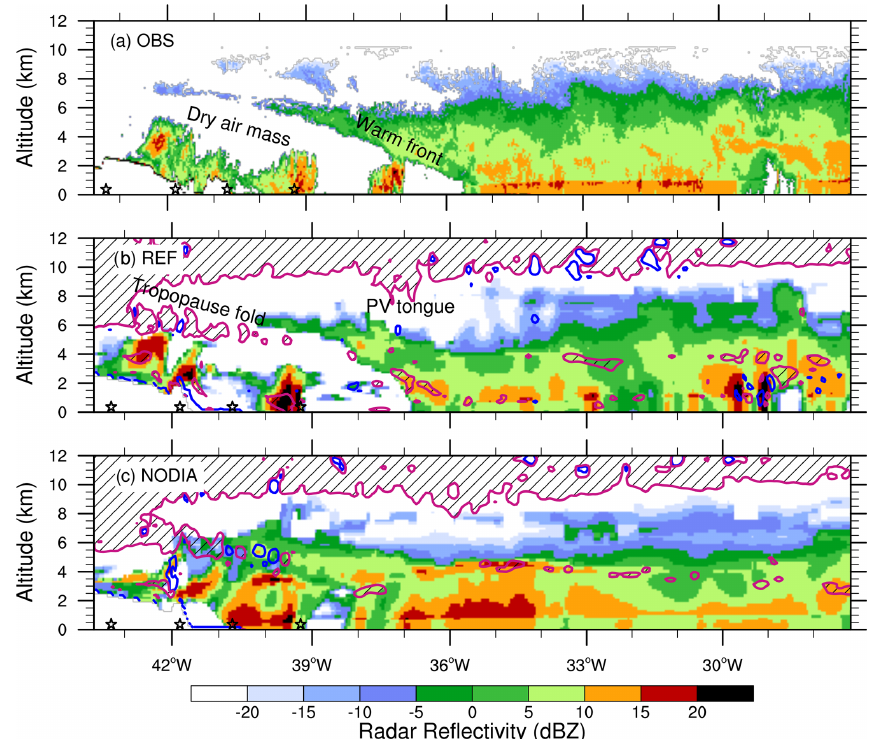
Figure 2. Reflectivity, in dBZ (a) , measured by RASTA and simulated by (b) REF and (c) NODIA along the 11:00UTC leg (black line in Fig. 1). The black stars show the position of the dropsondes shown in Fig. 4. In (b) and (c) , magenta and navy blue contours show PV values equal to 2 and − 1PVU, respectively, with hatching for PV values greater than